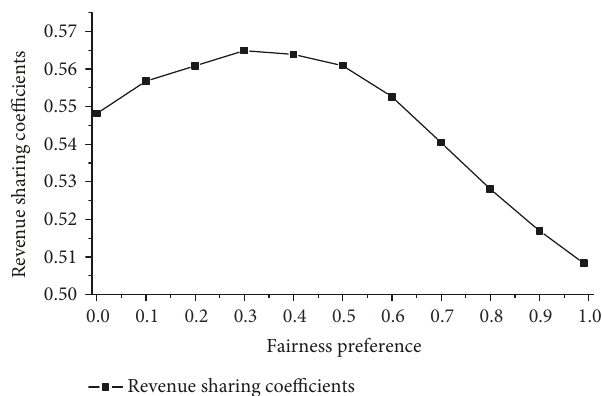
Figure 4: Revenue sharing coe ffi cients when empathy preference and jealous preference are the